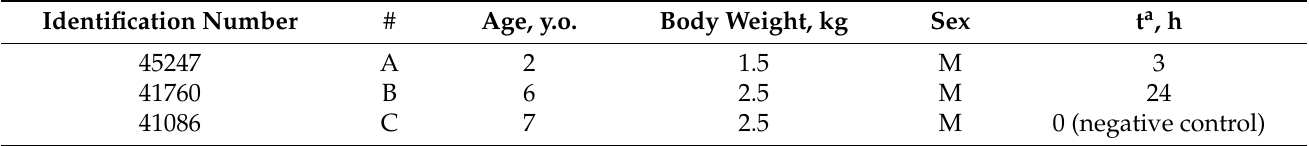
Table 1. Parameters of the experimental